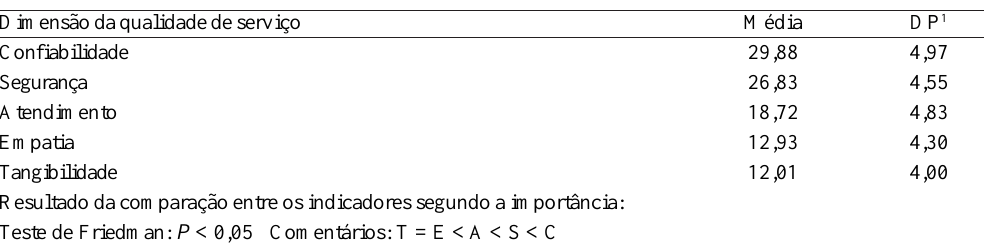
Tabela 5. Caracterização dos 82 pacientes que realizaram cirurgia cardíaca eletiva no serviço de cirurgia cardíaca da Santa Casa de Misericórdia de Marília, segundo a importância atribuída aos indicadores da qualidade do